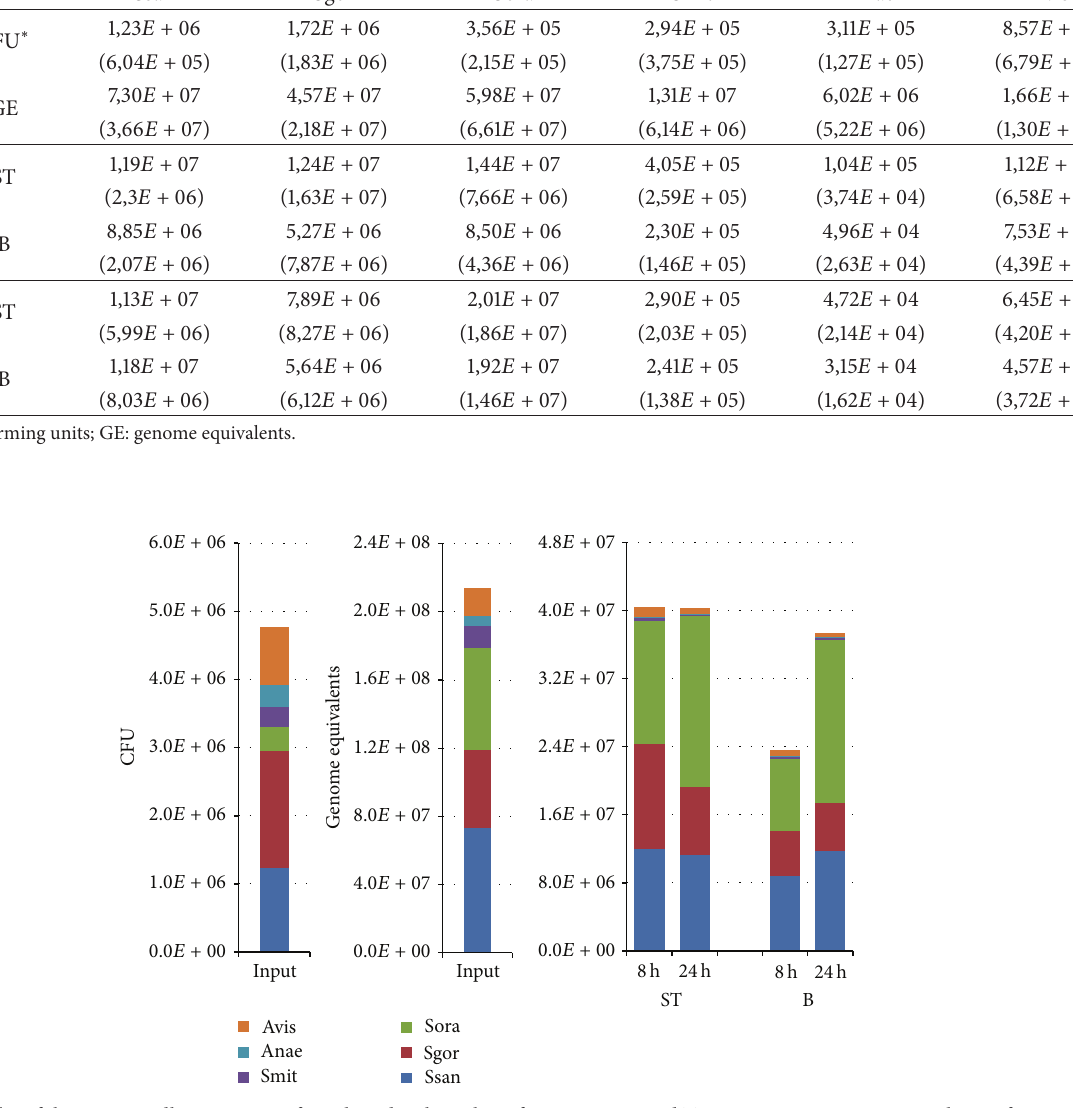
Figure 1: Results of the in vitro adhesion assay after 8 h and 24 h. Colony forming units and TaqMan-PCR genome equivalents of A. viscosus (Avis), A. naeslundii (Anae), S. mitis (Smit), S. oralis (Sora), S. gordonii (Sgor), and S. sanguinis (Ssan) in the inoculum (input) and attached to materials ST and B after 8h or 24 h